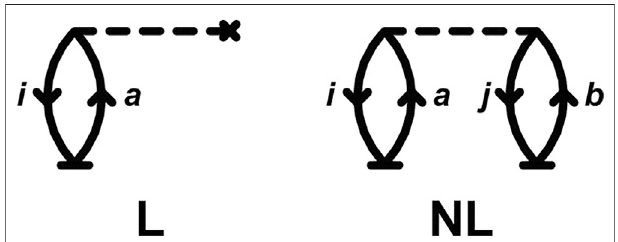
FIGURE 1 | Linear (L) and non-linear (NL) CC diagrams (Crawford and Schaefer,2000;Brandow, 1967) forthe time-derivative ofthecumulantin Eq. 14 . Unlike in traditional EOM-CC diagrams, the base vertices ( t ) are time- dependent.